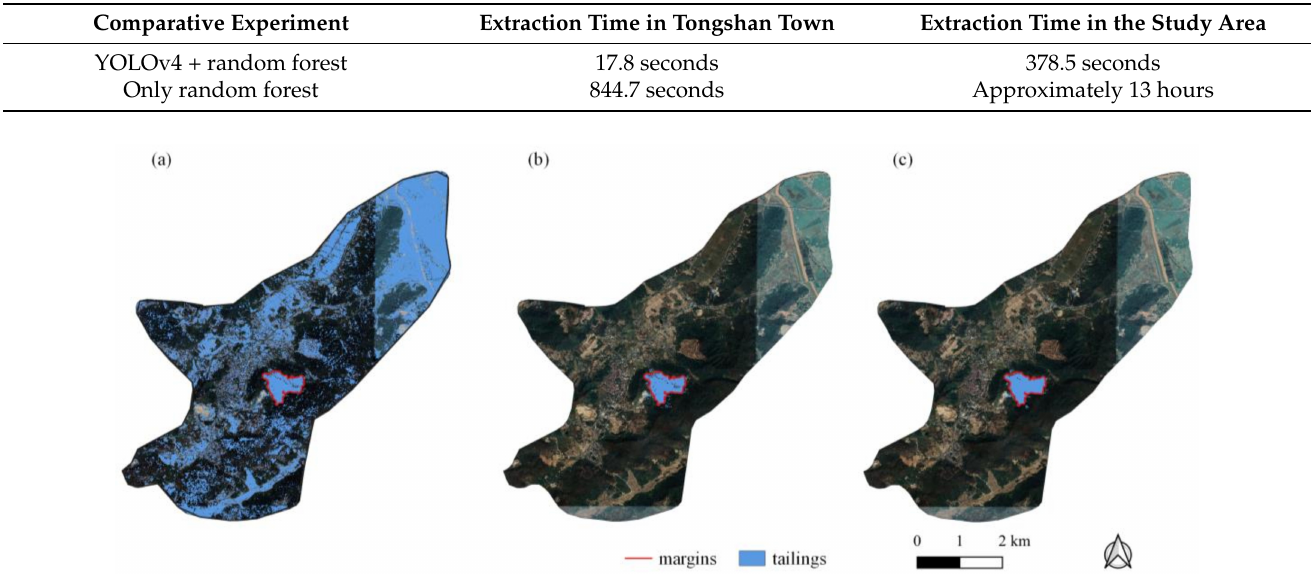
Table 4. Comparison of extraction time of tailings ponds based on different methods.